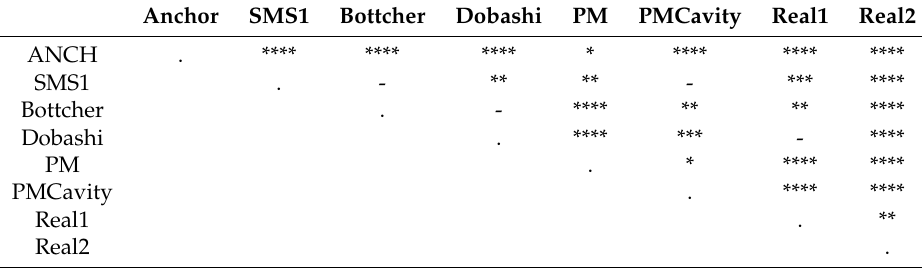
Table 8. The effect of different samples for a metal sword (**** ⇒ p < 0.0001, *** ⇒ p < 0.001, ** ⇒ p < 0.01, * ⇒ p < 0.05, - ⇒ p ≥ 0.05). SMS, spectral modelling synthesis; PM, physical model; PMCavity, physical model including cavity tone; Real, recorded